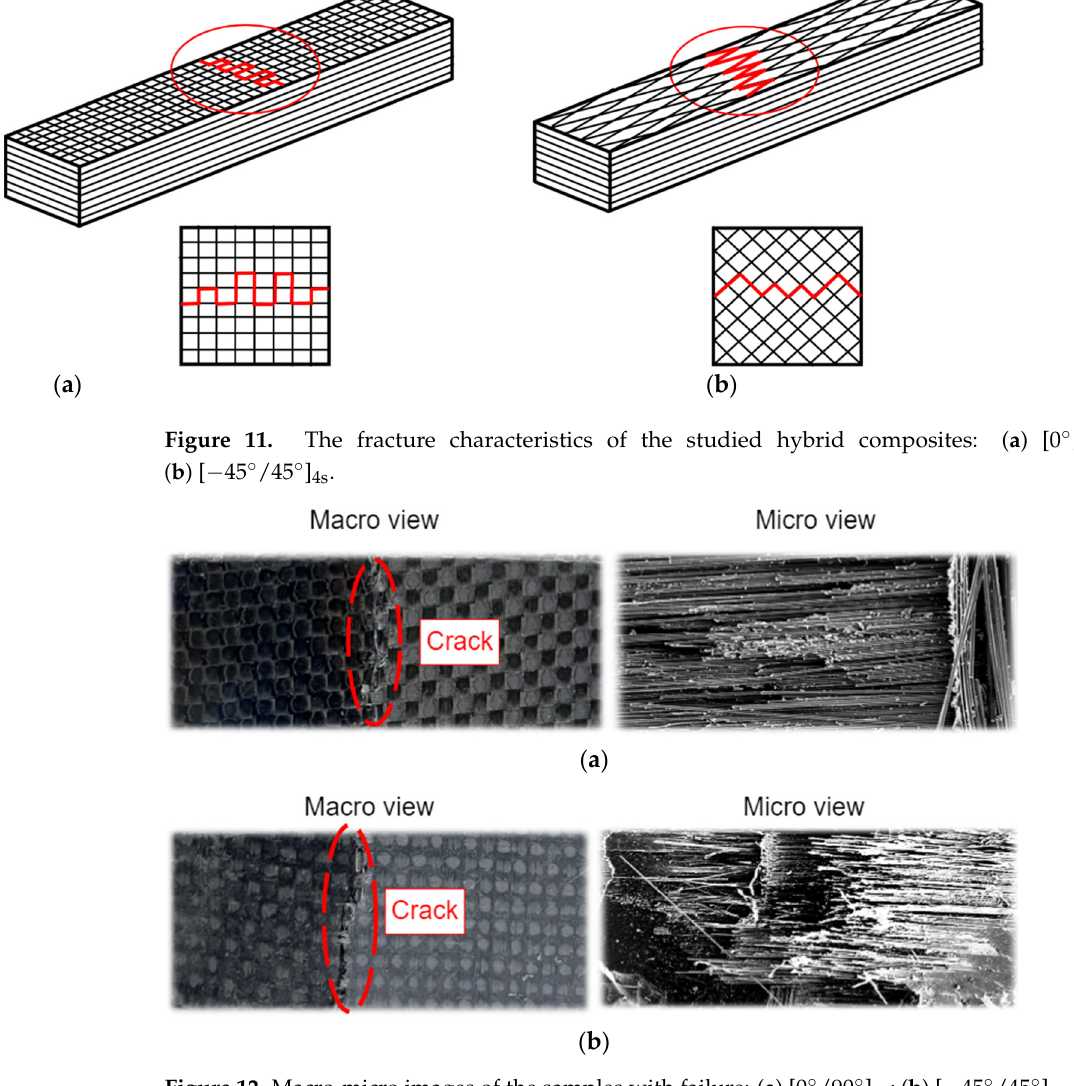
Figure 12. Macro-micro images of the samples with failure: ( a ) [0°/90°] 4s ; ( b ) [ − 45°/45°] 4s.